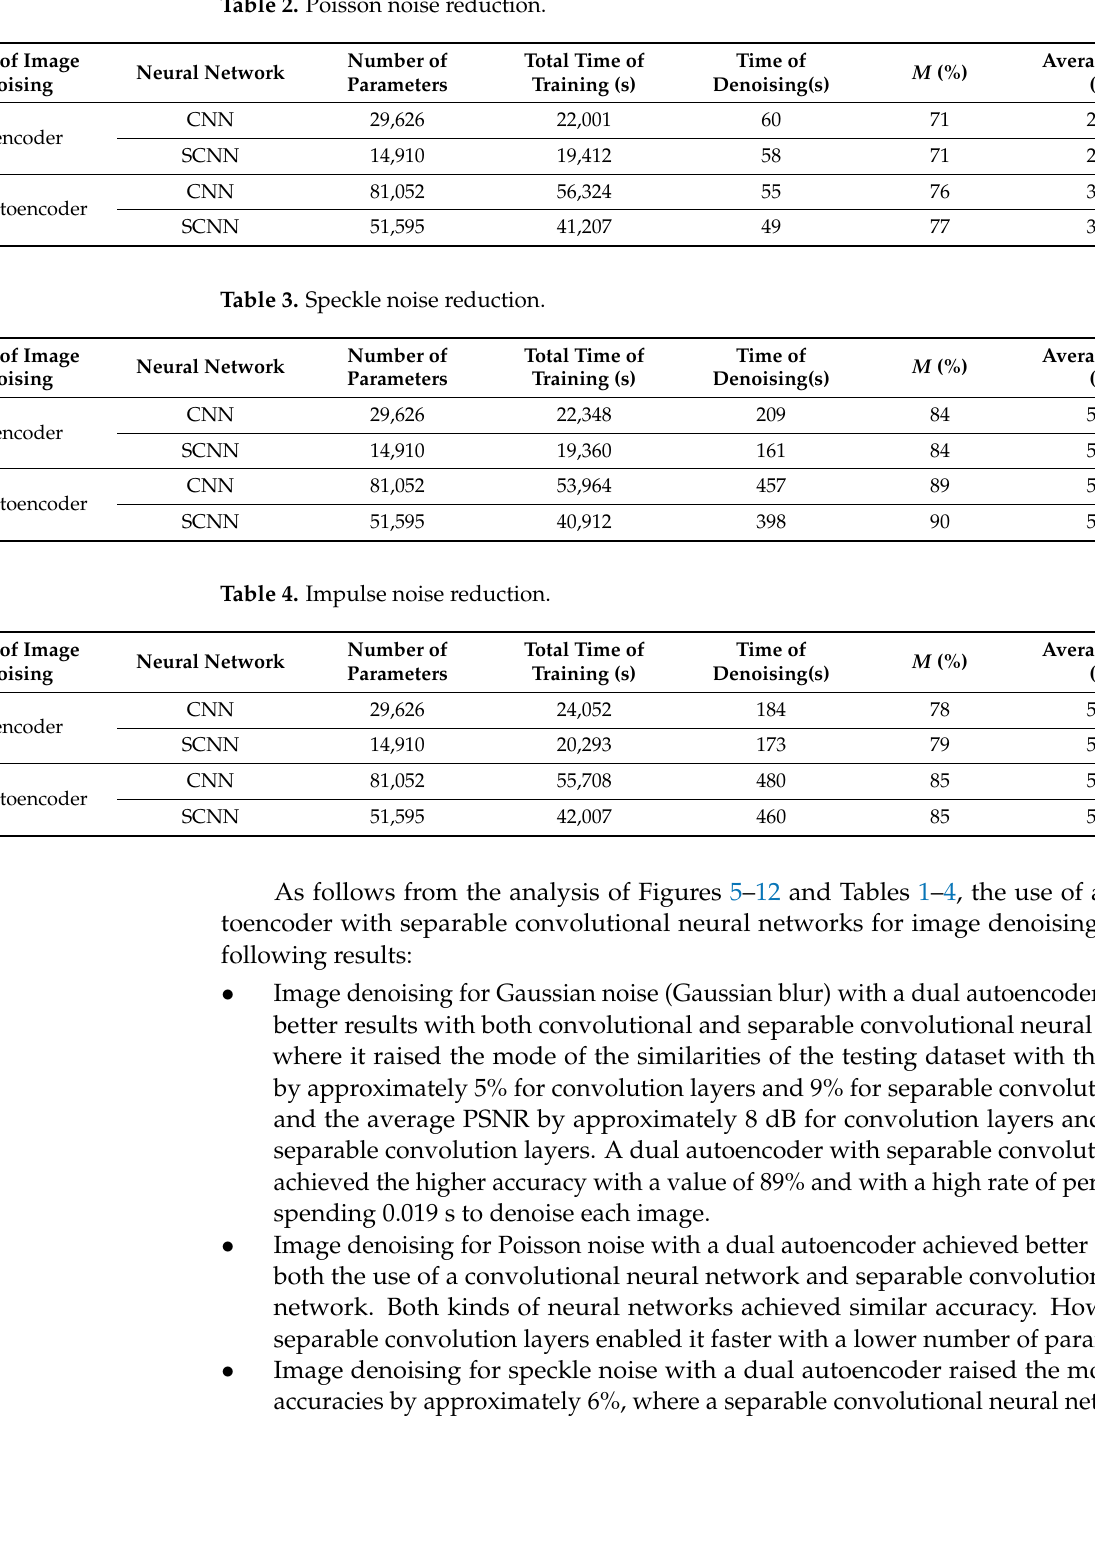
Table 2. Poisson noise reduction.